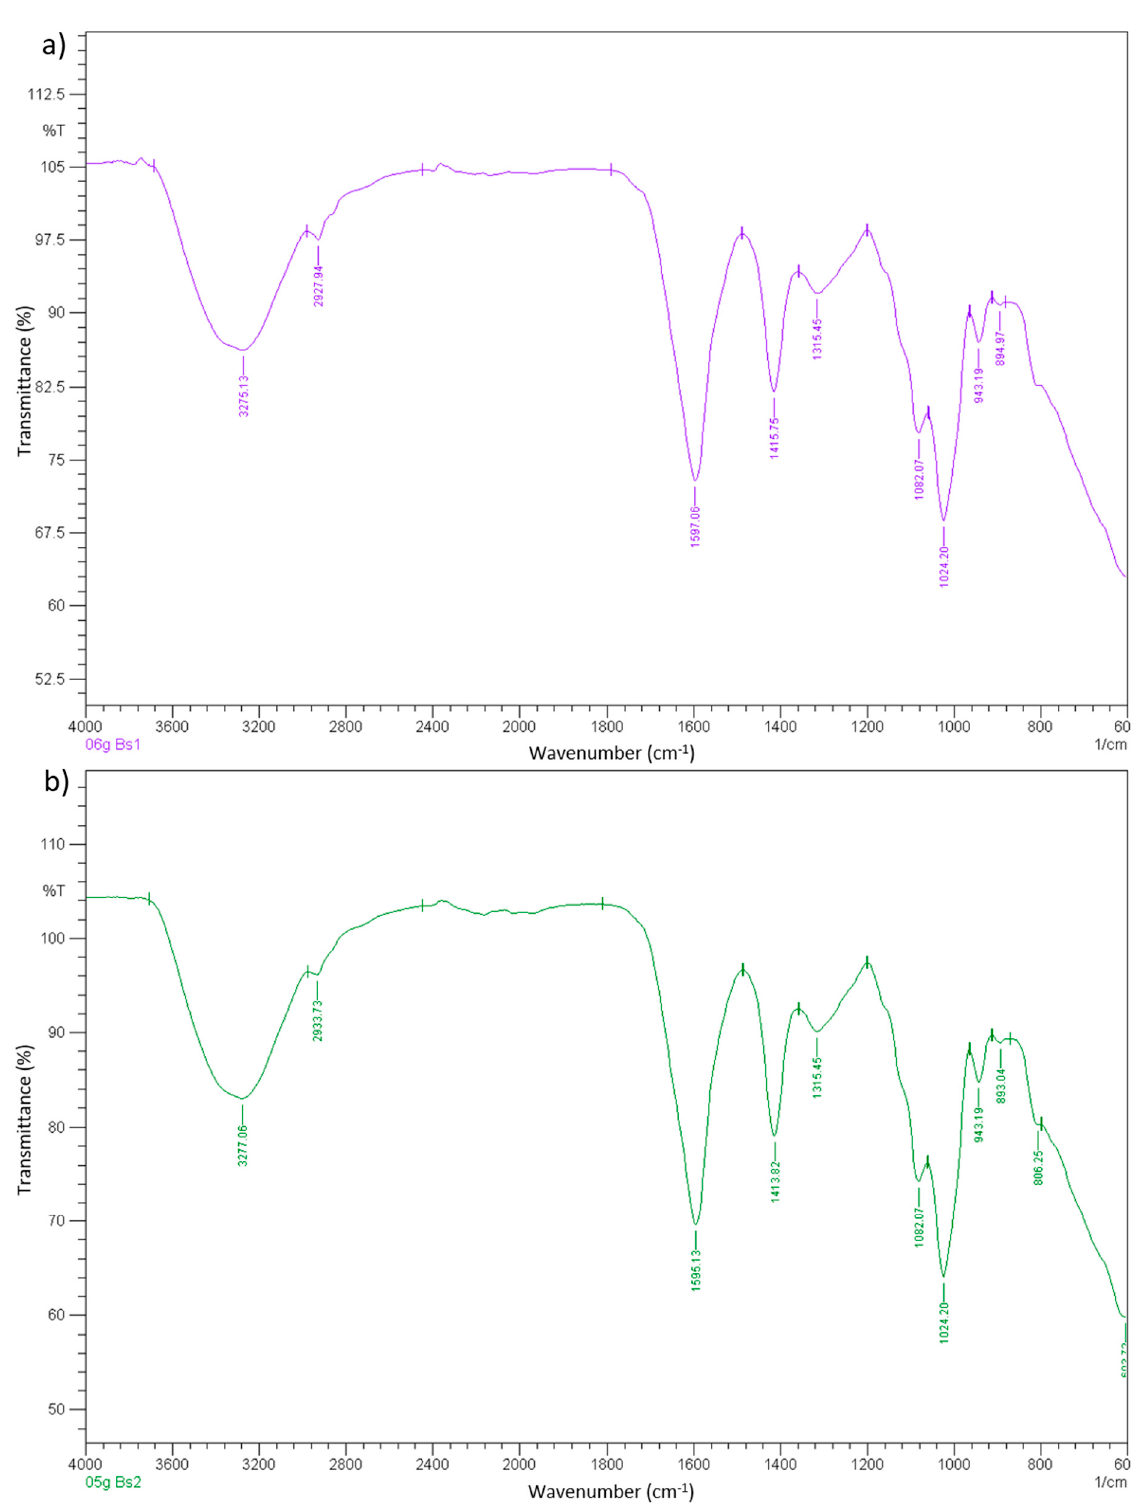
Figure 7. Fourier transform infrared spectroscopy (FTIR) graph of ( a ) sodium alginate film and ( b ) 0.5 g microbial composite film.